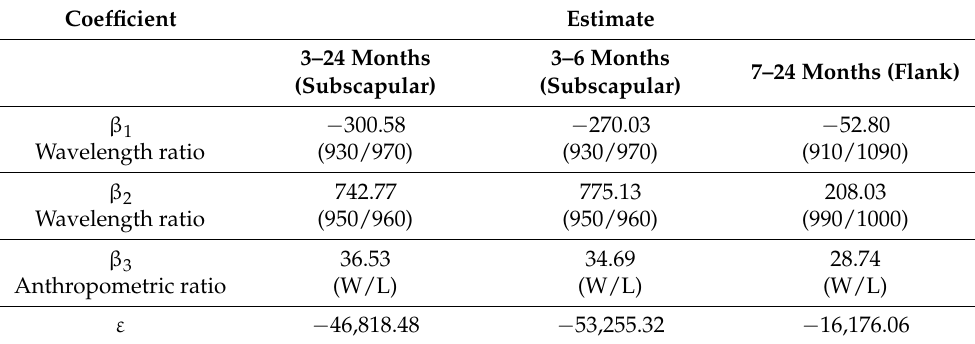
Table 2. Model wavelengths and coefficients. Scan locations are shown with age groups and wavelengths are in nm as shown in